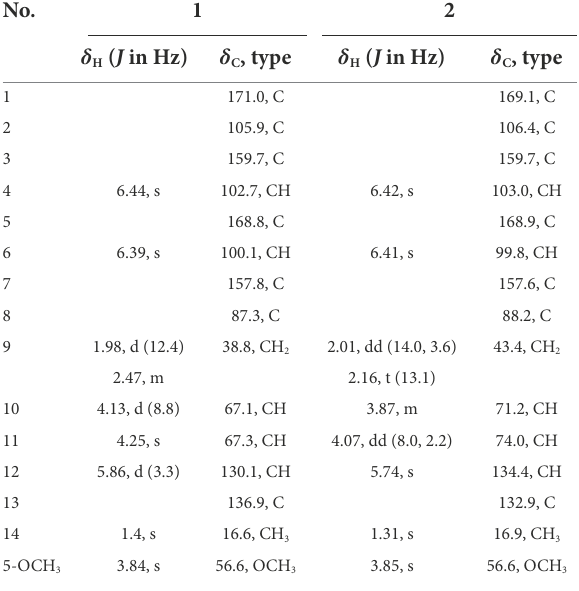
TABLE 1 1 H (600 MHz) and 13 C NMR (150 MHz) data of compounds (1–2).